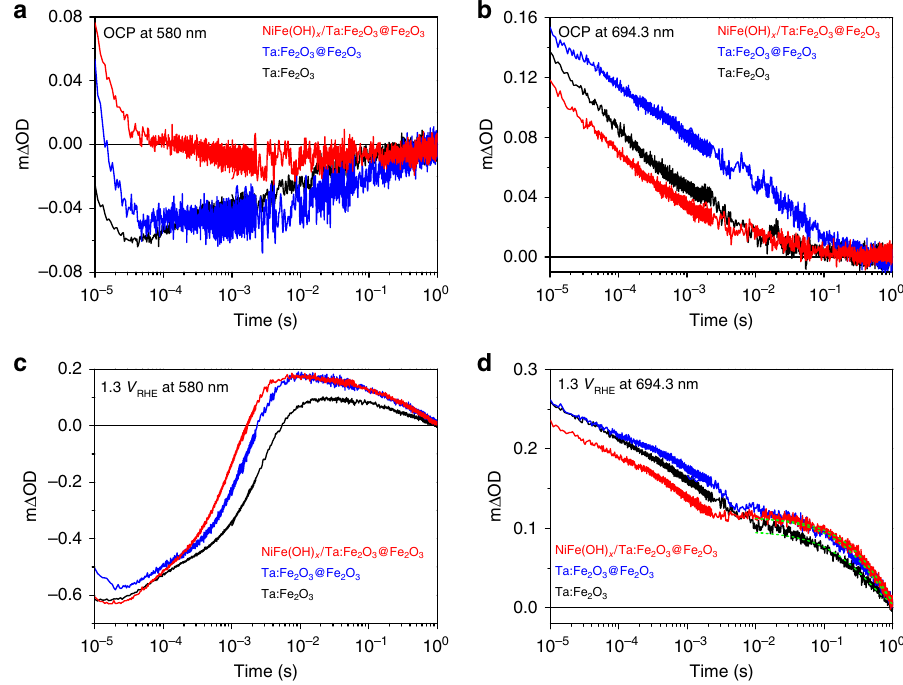
Fig. 6 Transient absorption spectroscopy (TAS) for Ta:Fe 2 O 3 , Ta:Fe 2 O 3 @Fe 2 O 3 , and NiFe(OH) x /Ta:Fe 2 O 3 @Fe 2 O 3 photoanodes. a OCP at 580 nm. b OCP at 694.3 nm. c 1.3 V RHE at 580 nm. d 1.3 V RHE at 694.3